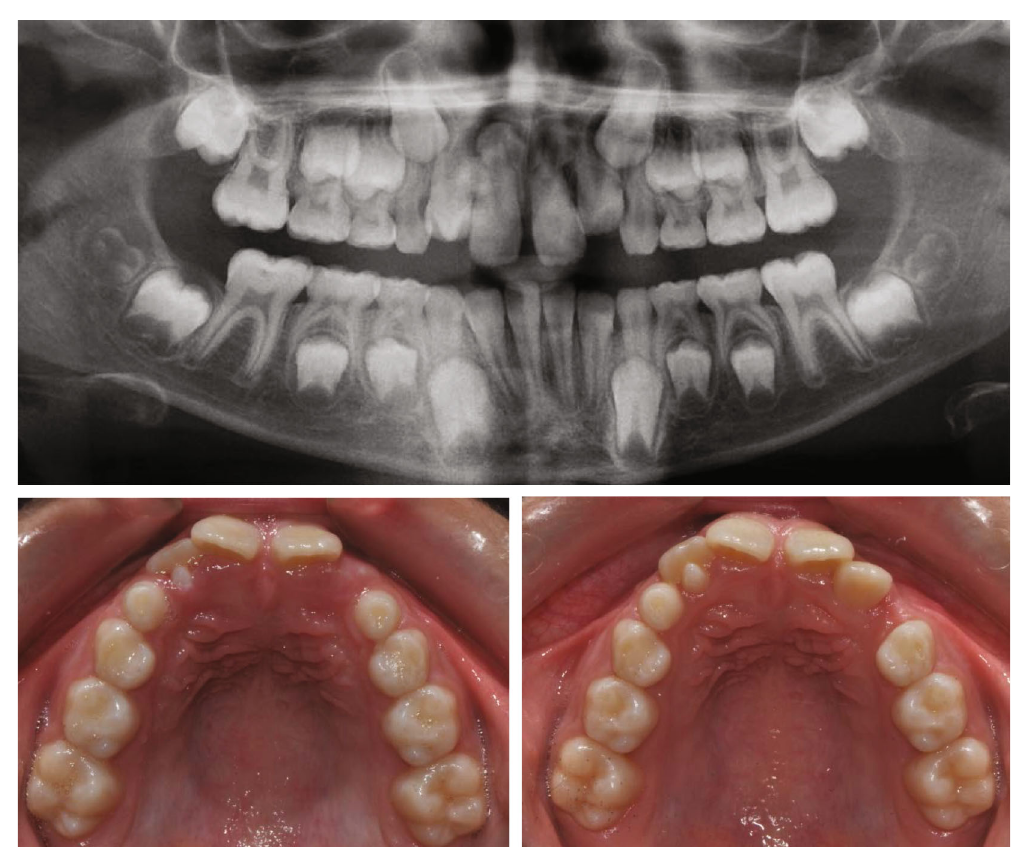
Figure 4: X-ray image and intraoral picture from the fi rst clinical examination and 4 months